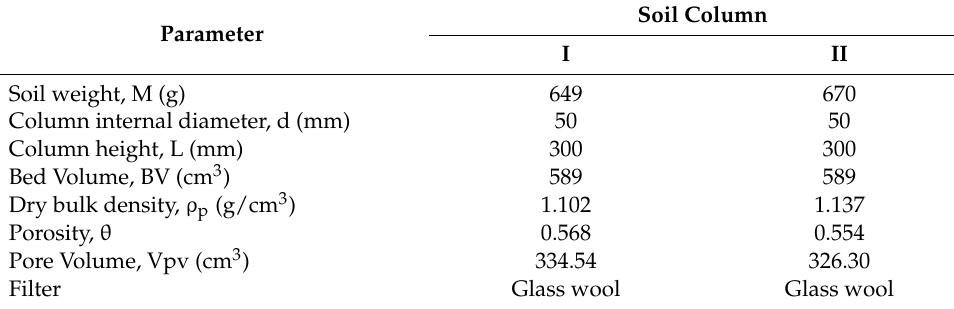
Table 2. Column properties and operating